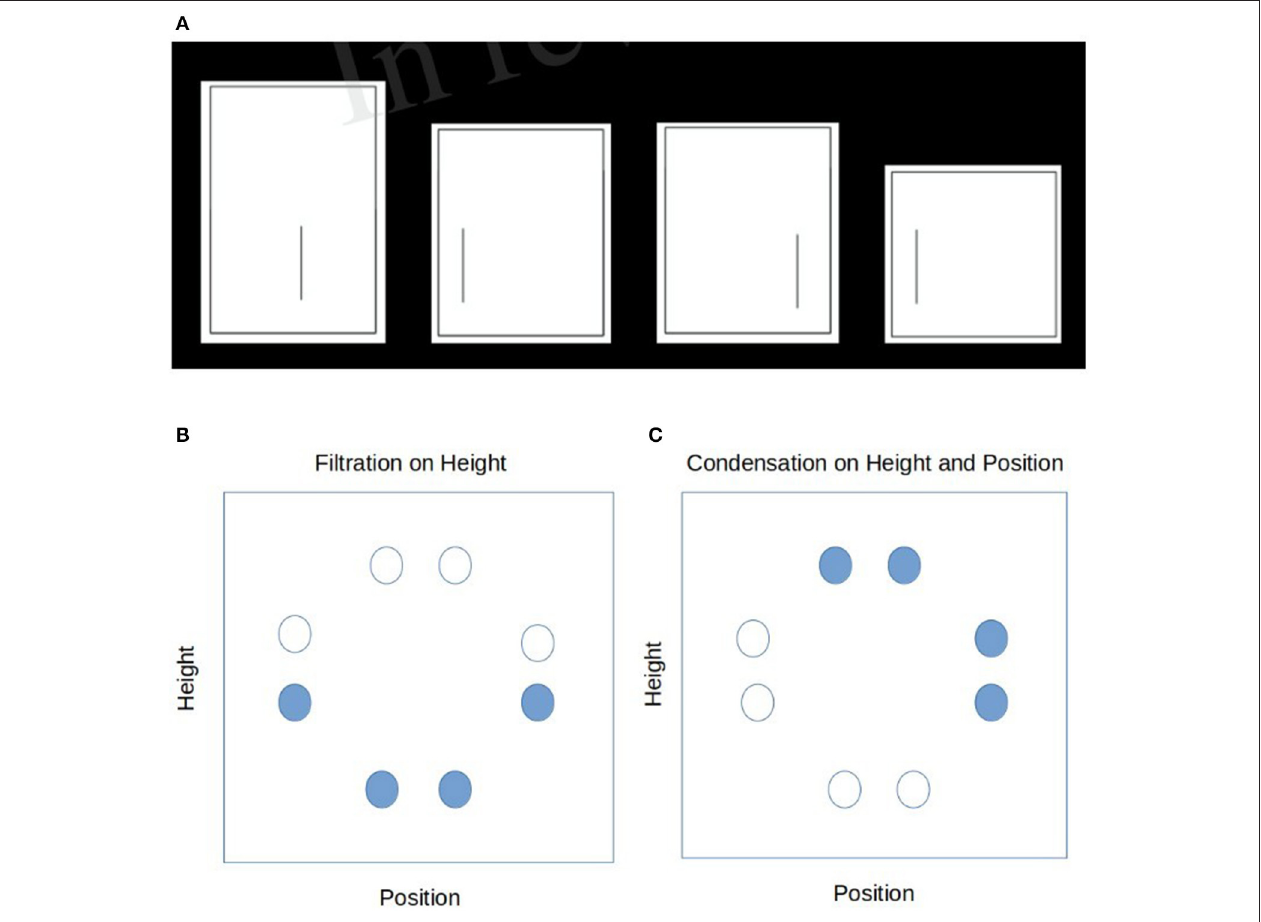
FIGURE 1 | Renditions of the original stimuli from Kruschke (1993) (A) a sample of 4 stimuli in the low dimensional categorization (B) the filtration rule applied to the 8 stimuli as indicated in the 2-d feature space. (C) The condensation rule applied to the 8 stimuli as indicated in the 2-d feature